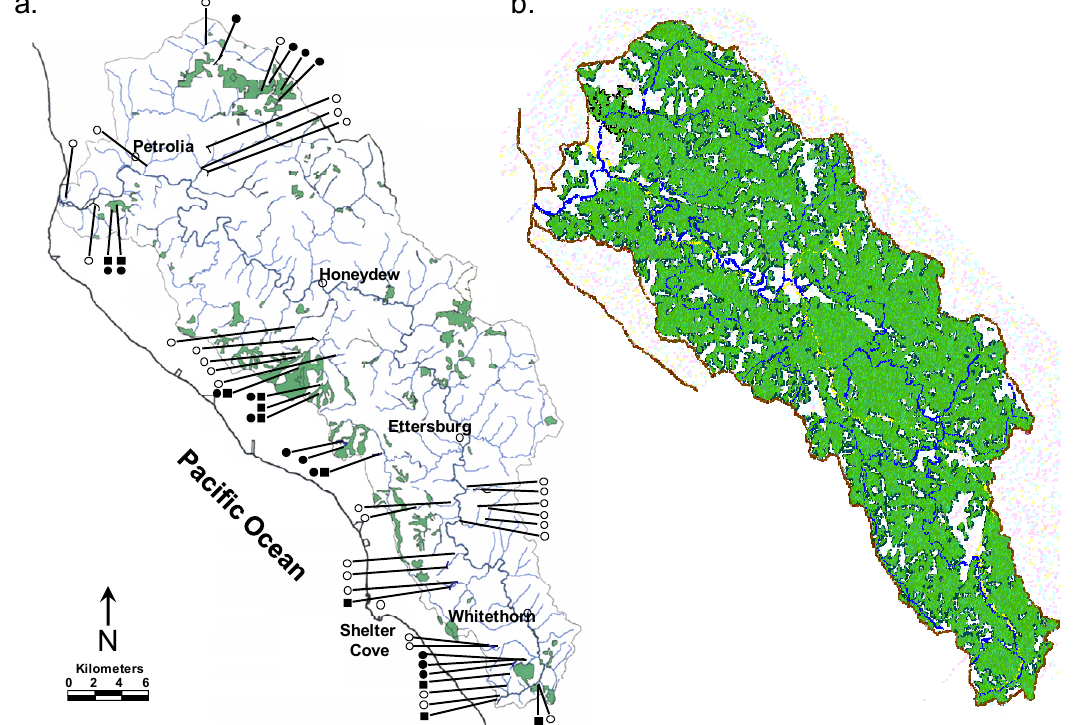
Figure 6. ( a ) Detections of tailed frogs (closed circles) and torrent salamanders (closed squares) in tributaries of the Mattole River watershed. Green shading indicates remaining unharvested late-seral forests. Open symbols indicate sampling without detections. Data from Welsh et al. [51]; ( b ) Map of late-seral forests (green shading) in the Mattole watershed on northwest California in 1947. Modified from Mattole Restoration Council maps published in 1988 and 1997. a.